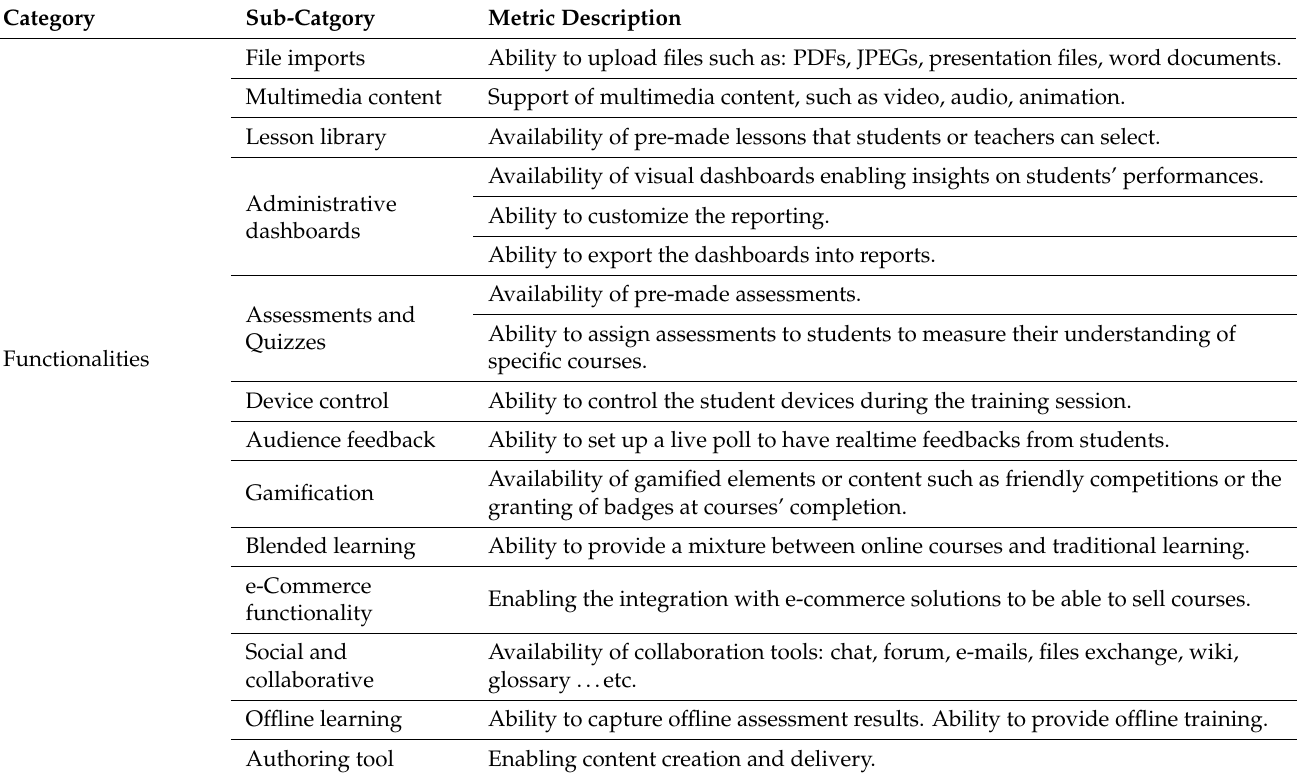
Table 1. OpenBRR tailored assessment